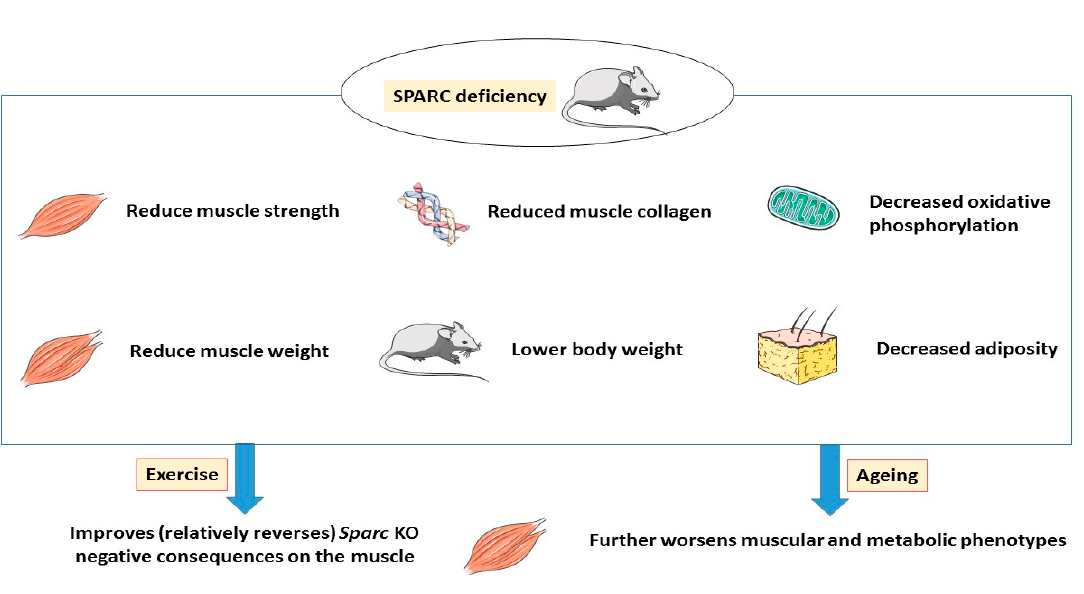
Figure 2. SPARC-deficiency impacts. Our data highlight that Sparc KO effects are toward a reduced body and white adipose tissue weights with a negative skeletal muscle phenotype (metabolic and strength). Such negative effects worsen with ageing but relatively improve through